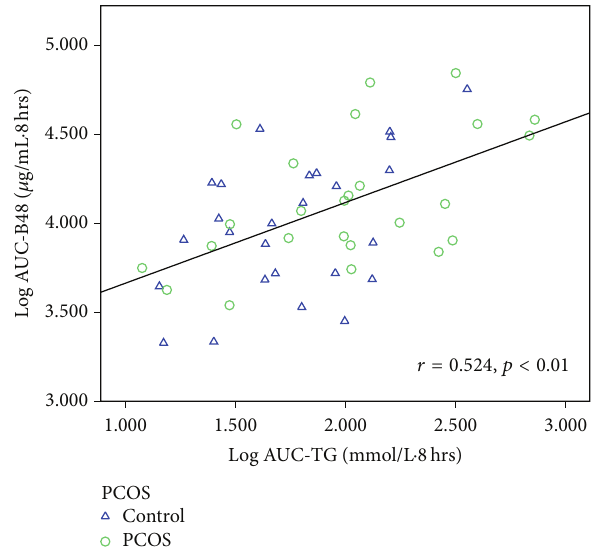
Figure 10: Correlation between AUC-TG and